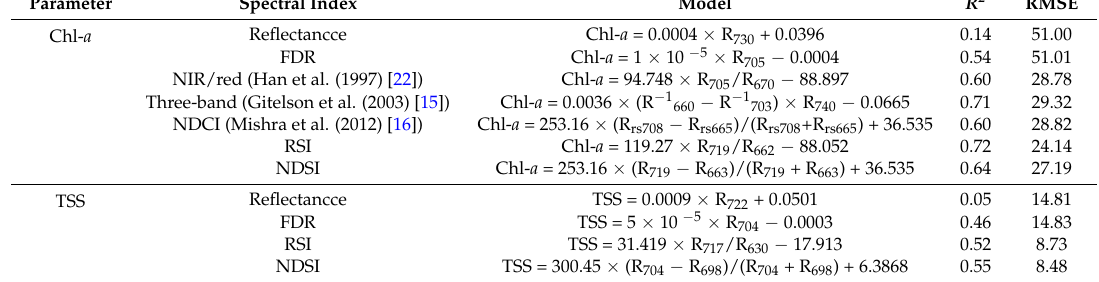
Table 3. Regression models used to estimate Chl- a and TSS concentrations with two spectral data types (reflectance and FDR) and two spectral indices (RSI and NDSI).